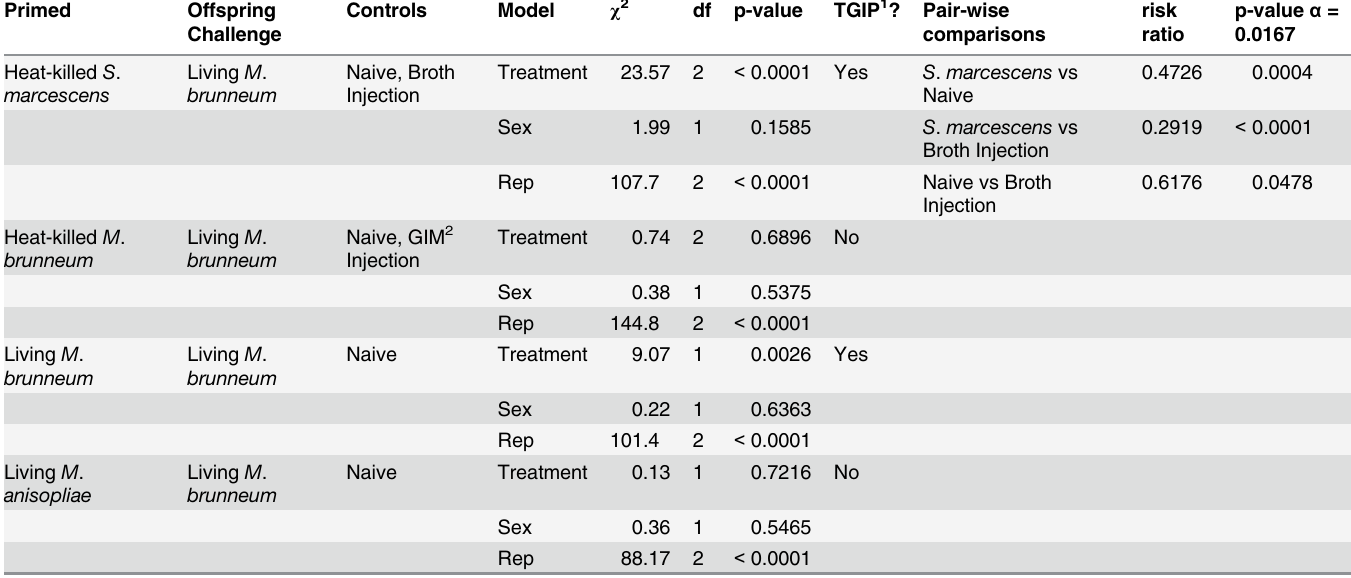
Table 1. Offspring (F1 generation) bioassay experimental design and